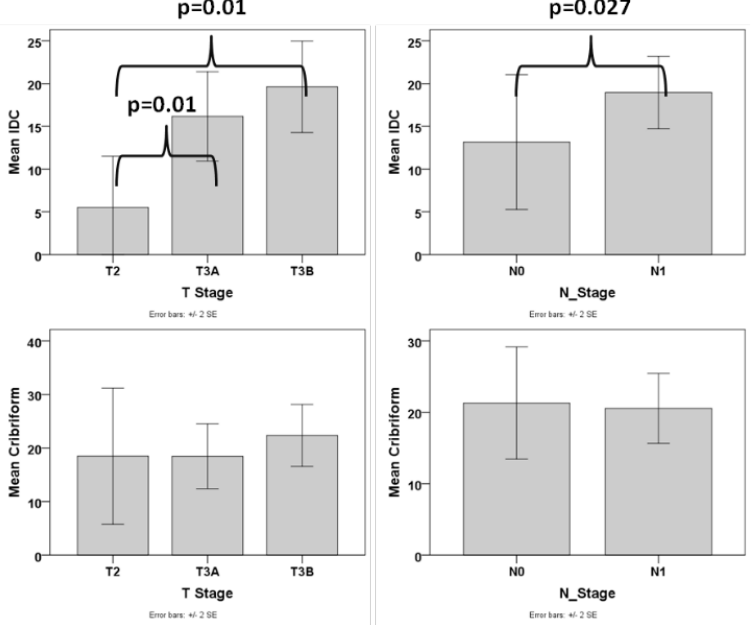
Figure 4. Box plot graphs of the correlation of IDC and Cribriform with T and N stage.